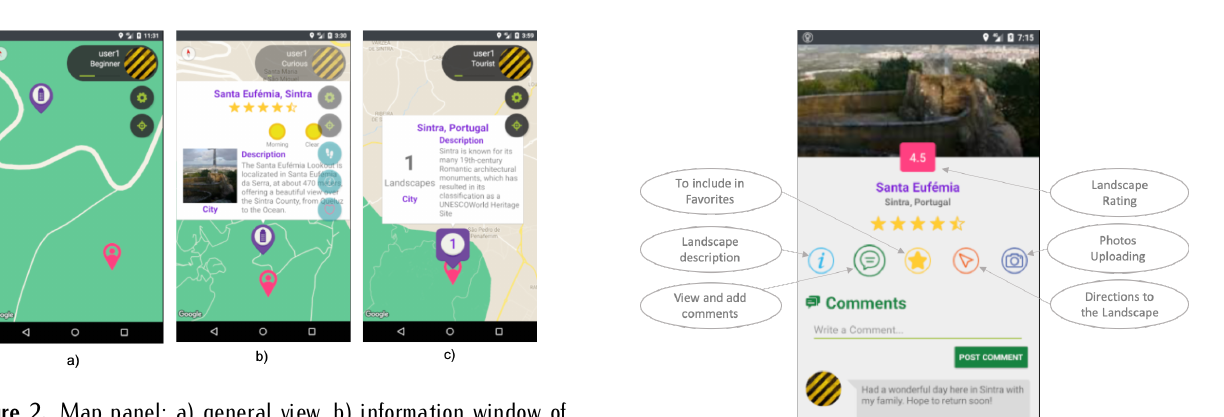
Figure 2. Map panel: a) general view, b) information window of the place, c) information window of the region.